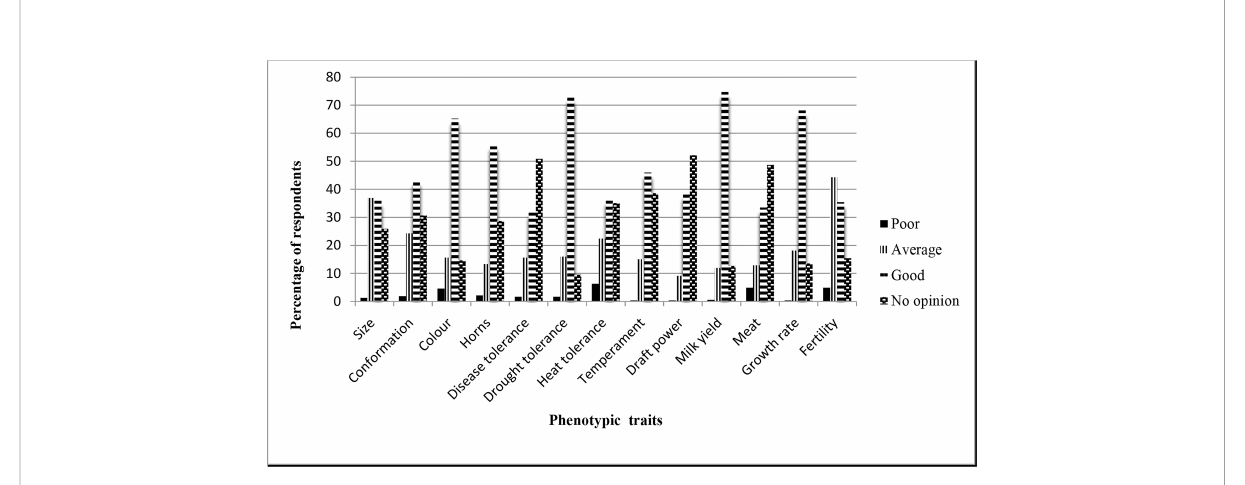
FIGURE 5 Ranking of the phenotypic quality traits of Fogera cattle.